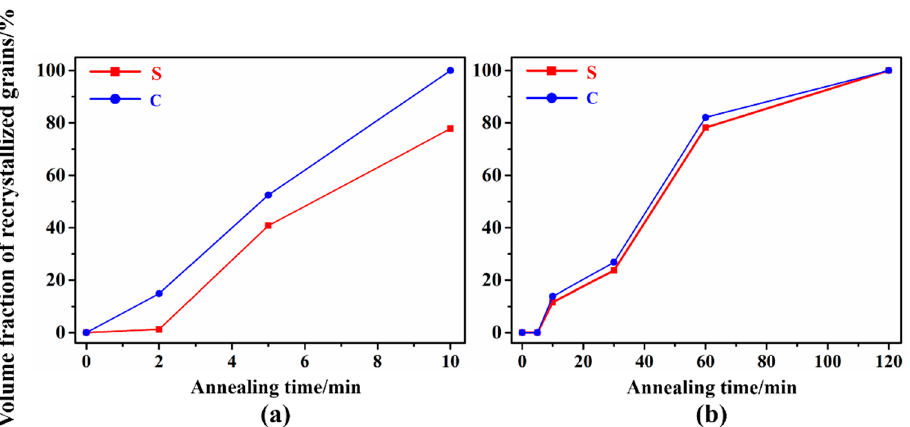
Figure 9. The volume fractions of recrystallized grains with annealing times at the surface and center regions of the UR and CR-Ta samples: ( a ) UR-Ta; ( b ) CR-Ta.